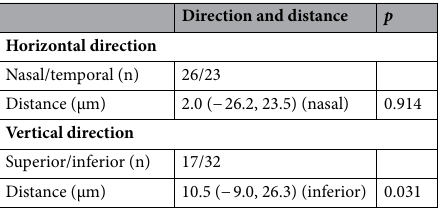
Table 2. Distance to the positional location of the foveal avascular zone from the highest foveal bulge point. Data are presented as numbers or median (interquartile range). * p values obtained using a one-sample Wilcoxson signed rank test with a reference value of